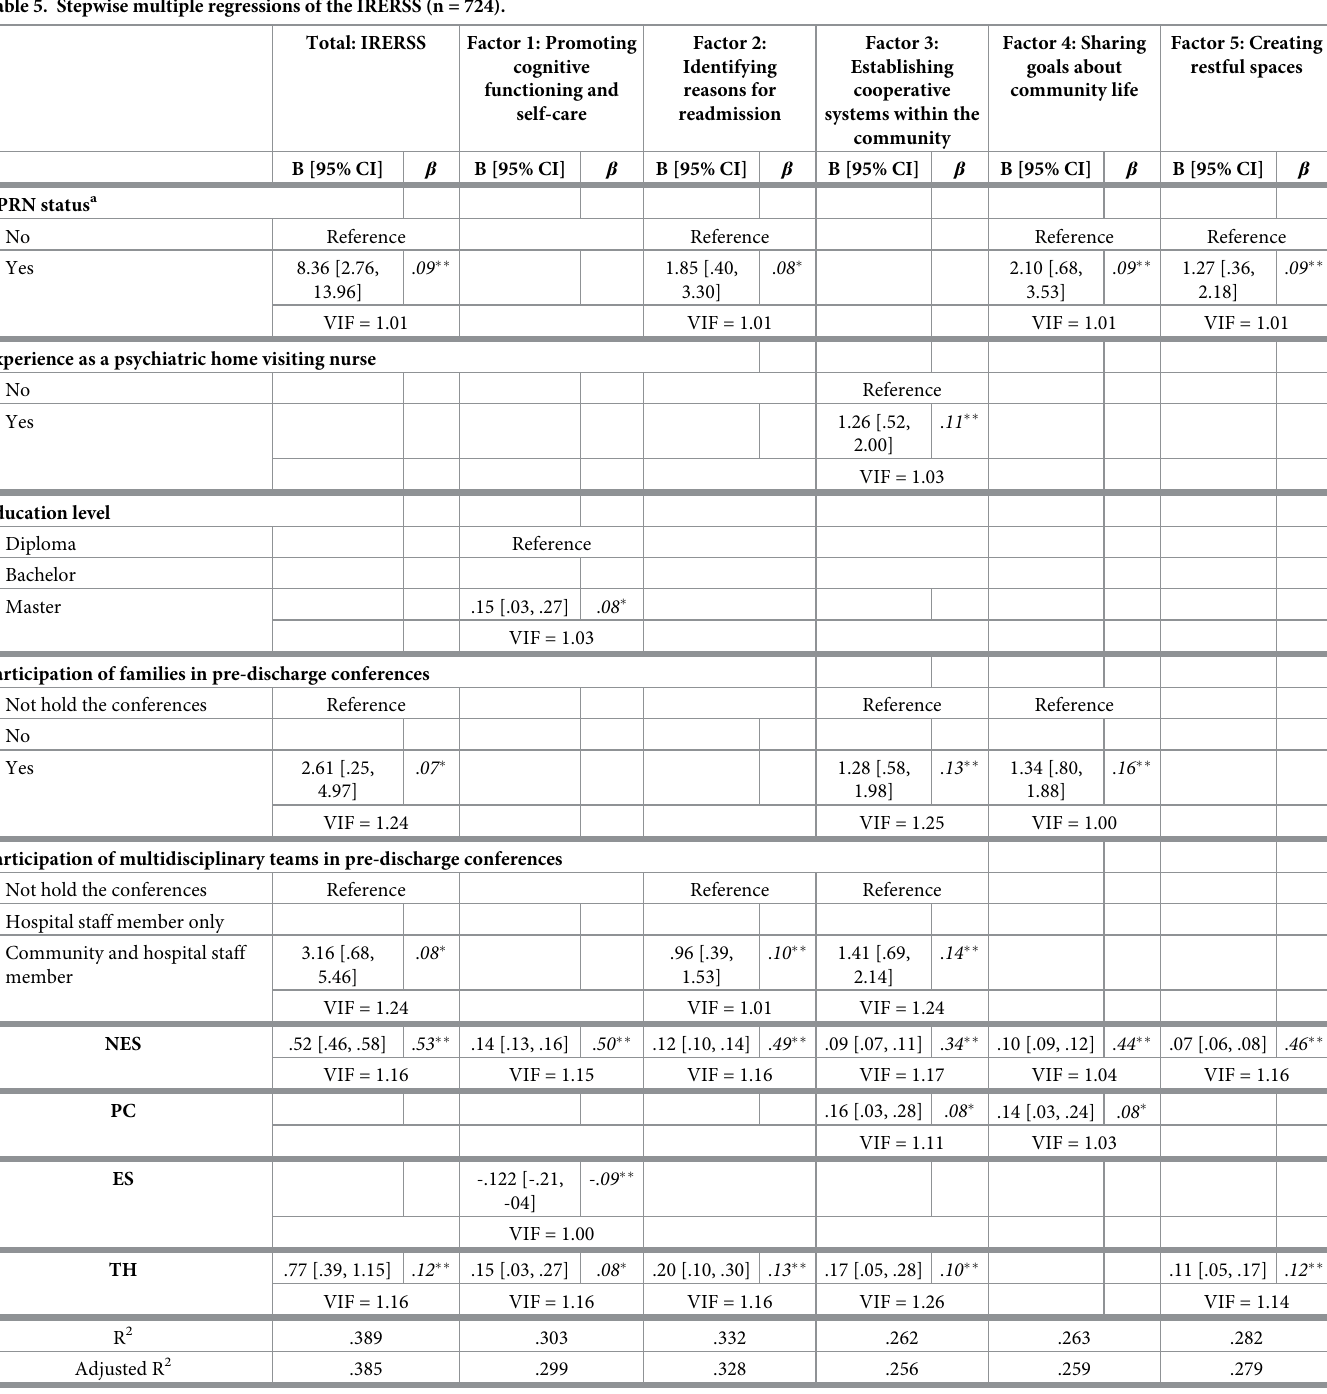
Table 5. Stepwise multiple regressions of the IRERSS (n =